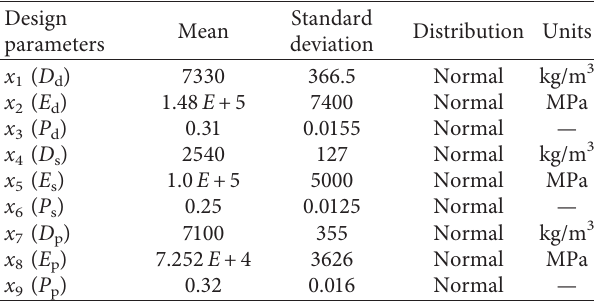
Table 8: The mean and standard deviation of the design